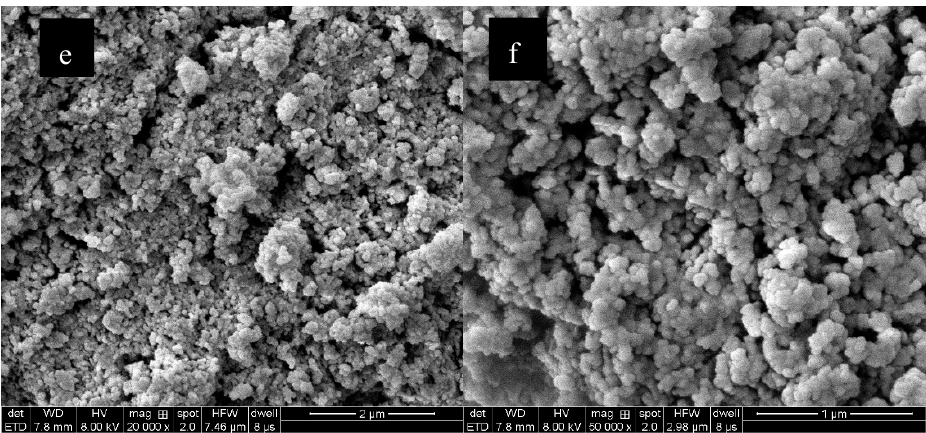
Figure 2. SEM images of Mn0 ( a , b ), Mn5 ( c , d ) and Mn15 ( e , f ).